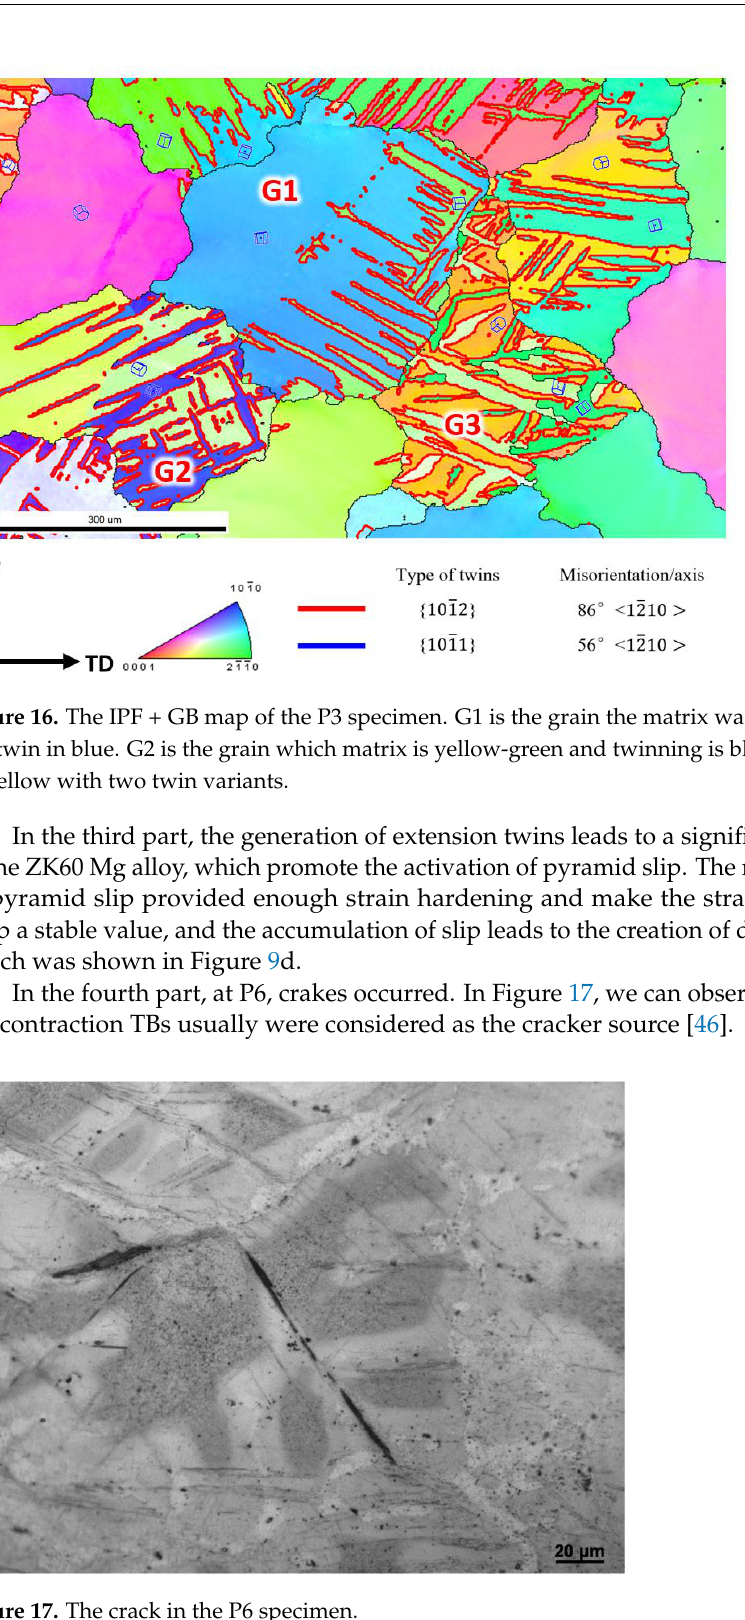
Figure 18. The hardness and strain hardening rate evolution with true strain.